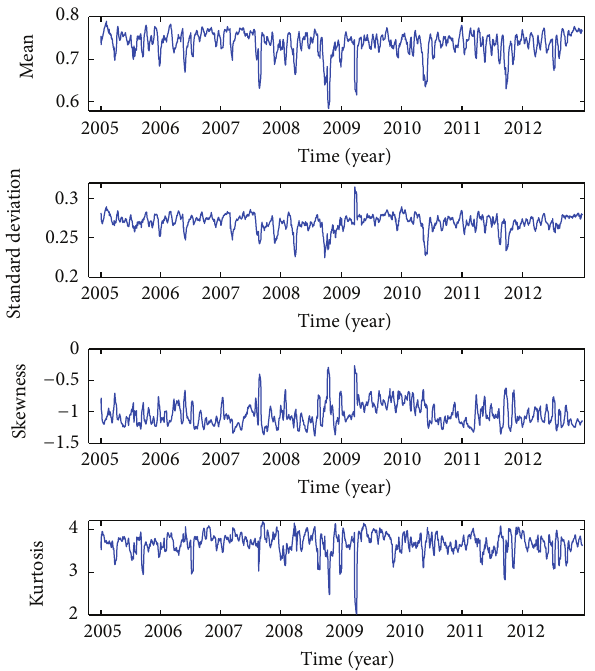
Figure 2: The mean, standard deviation, skewness, and kurtosis of distances of MST of 42 currencies in the international FX market as functions of